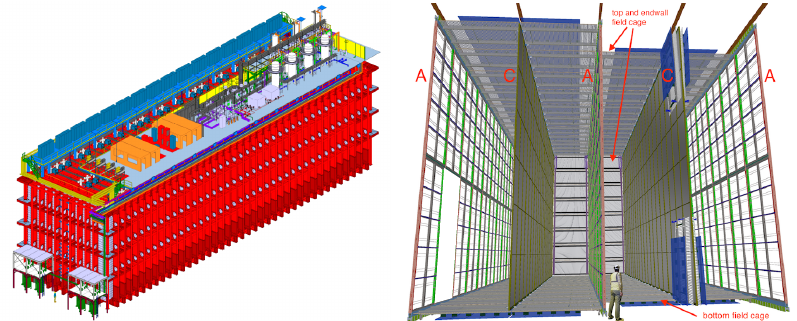
Figure 3. Left) A far detector cryostat that houses a 10 kT FD module. The figure of a person indicates the scale. Right) A 10kt DUNE FD SP module, showing the alternating 58 m long (into the page), 12 m high anode (A) and cathode (C) planes, as well as the field cage that surrounds the drift regions between the anode and cathode planes. The blank area on the left side was added to show the profile of a single anode plane assembly